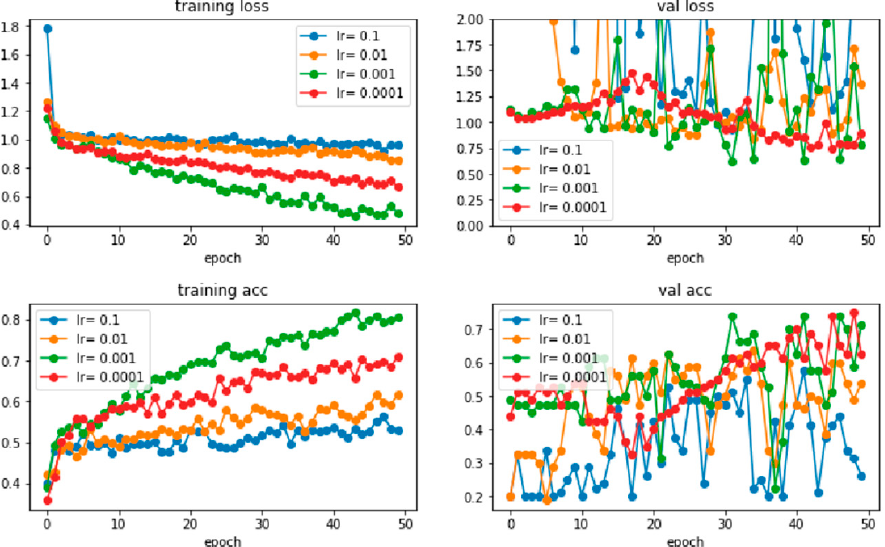
Figure 14. The training loss, validation loss, training accuracy, and validation accuracy of learning rates range from 0.0001 to 0.1 with 50 epochs and a batch size of 32.